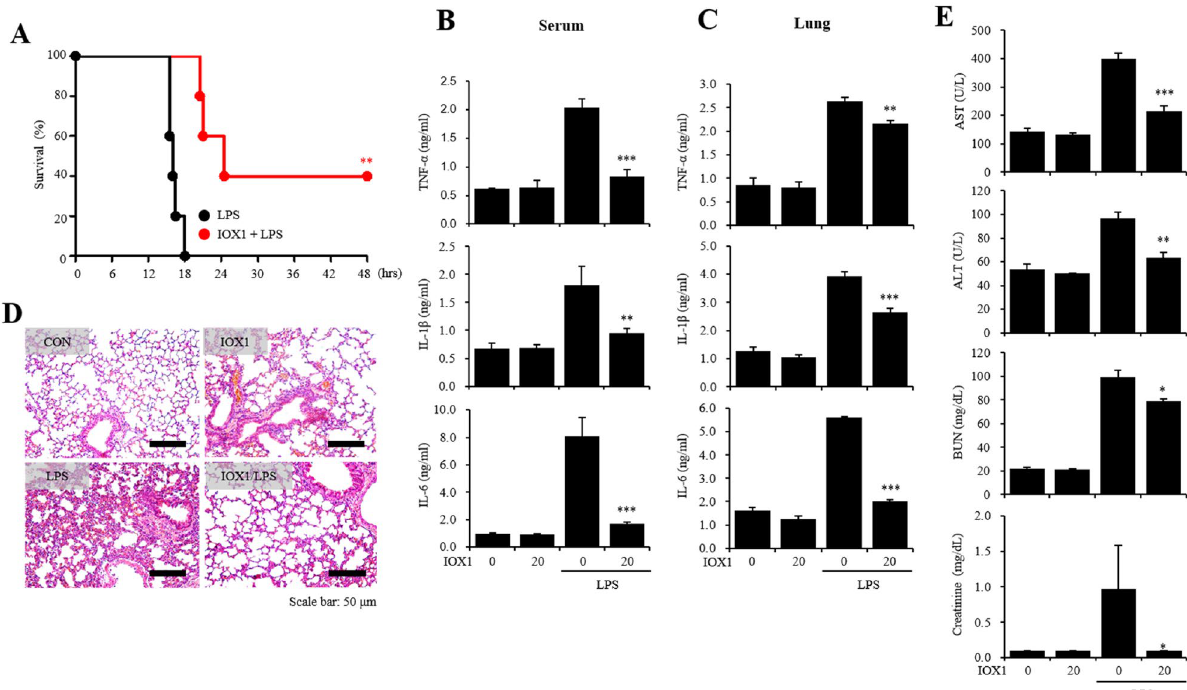
Figure 3. IOX1 anti-inflammatory effects on an LPS-induced endotoxemia mouse model. Six-week-old female BALB/c mice were intraperitoneally injected with IOX1 (20 mg/kg). After 30 min, the mice were i.p. injected with LPS. ( A ) The survival rates of IOX1- and LPS (20 mg/kg)-injected mice were monitored for 48 h. ( B ) The serum of IOX1- and LPS (20 mg/kg)-injected mice were harvested 2 h after LPS injection. The levels of serum proinflammatory cytokines (TNF-α, IL-1β and IL-6) were measured by sandwich ELISA kits. ( C–E ) After overnight incubation, IOX1- and LPS (10 mg/kg)-injected mice were sacrificed for experiments. ( C ) The